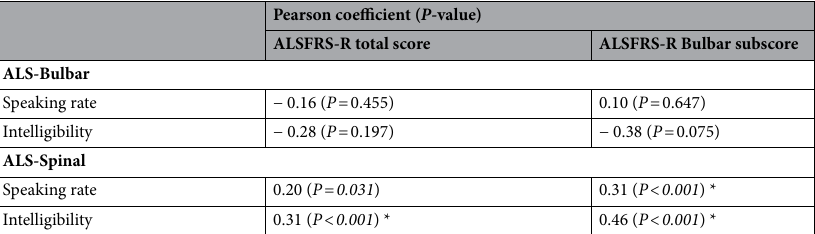
Table 6. Pearson correlation coefficients for the association between longitudinal changes in speech measures and ALSFRS scores. Asterisks represent correlations that remained statistically significant after adjusting p-values for multiple testing (adjusted p-value =